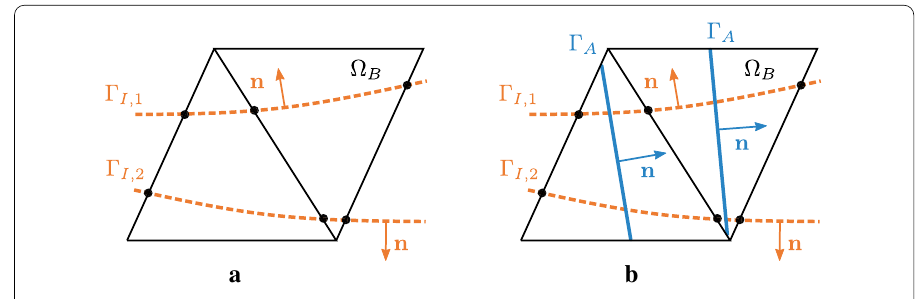
Fig. 19 Improper / misaligned approximation of cutting plane in case several boundaries are intersecting a single background element. a Several boundaries intersecting a single element. b Wrong approximation of cutting plane following a best-fit